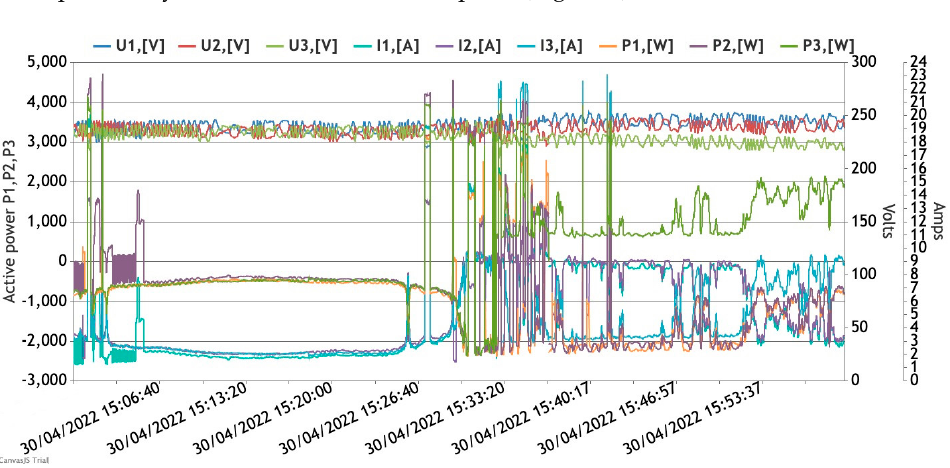
30 April 2022. Figure 5 (also https://remotelab.lv/power/powerD2.php (accessed on 1 March 2023)) reflects measured voltage, current, power, and power factor curves for each phase in the three-phase Y system at the measurement point (Figure 1).